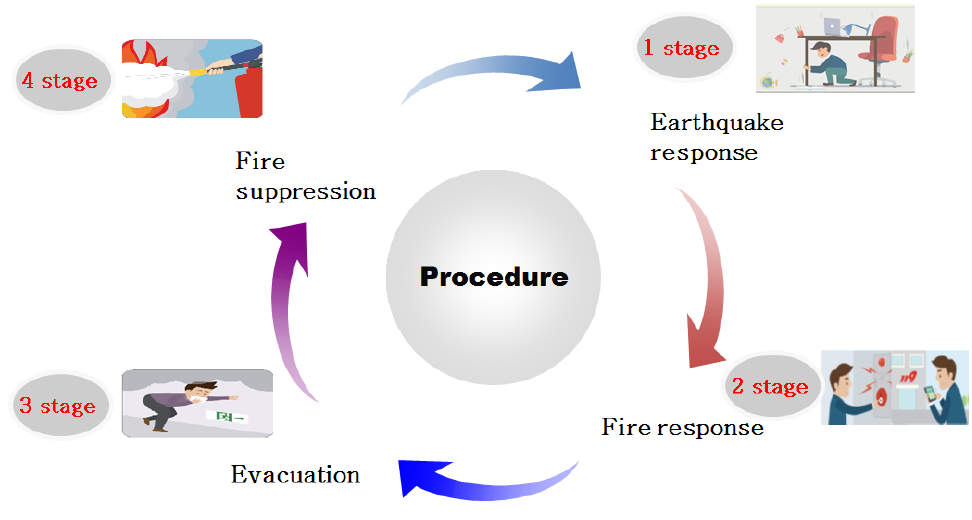
Figure 2. Simulation protocol procedure. Table 3. Simulation protocol for earthquake fire response. Table 4. Simulation protocol for earthquake fire